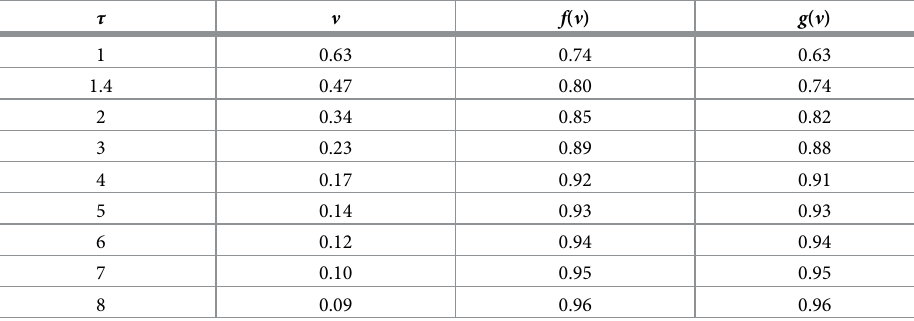
Table 5. ν as a function of τ , the doubling